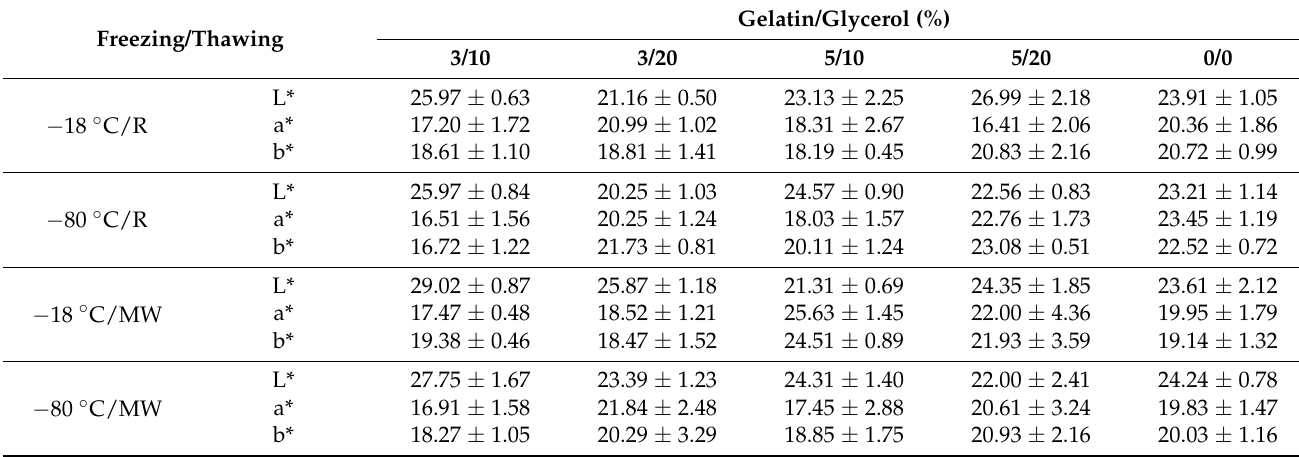
Table 7. Coated and uncoated meat color values ± SD depending on the method of freezing and